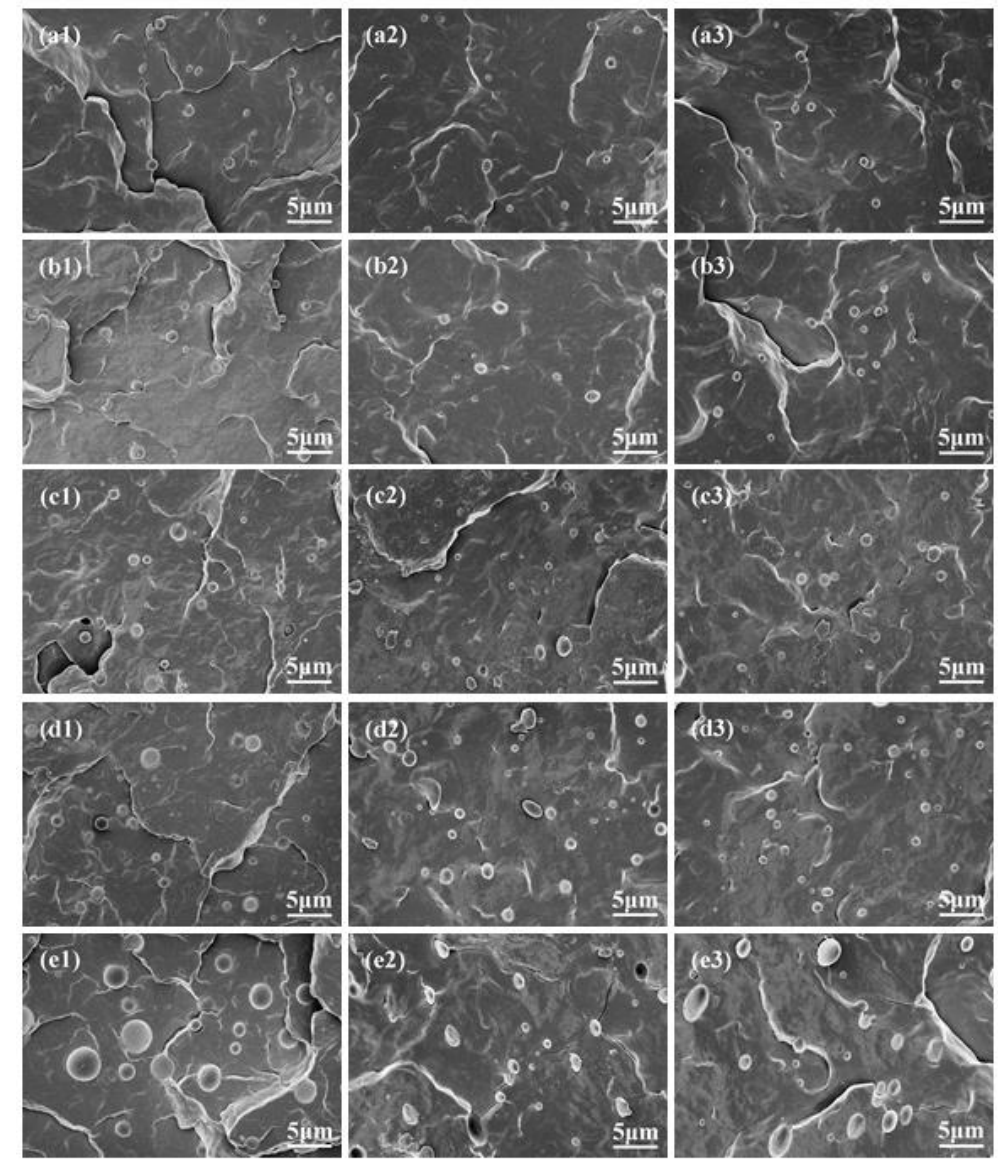
Figure 8. SEM micrographs of iPP/ABS blends. ( a ) P-0.3A, ( b ) P-0.7A, ( c ) P-1A, ( d ) P-2A, ( e ) P-4A. ( a1 – e1 ) compression-molded samples, ( a2 – e2 ) skin region of injection-molded specimens, ( a3 – e3 ) core region of injection-molded specimens. Table 3. The number-average diameter ( D n ), weight-average diameter ( D w ), volume-average diameter ( D v ), and polydispersity (PD) of ABS dispersed phase in iPP/ABS blends.